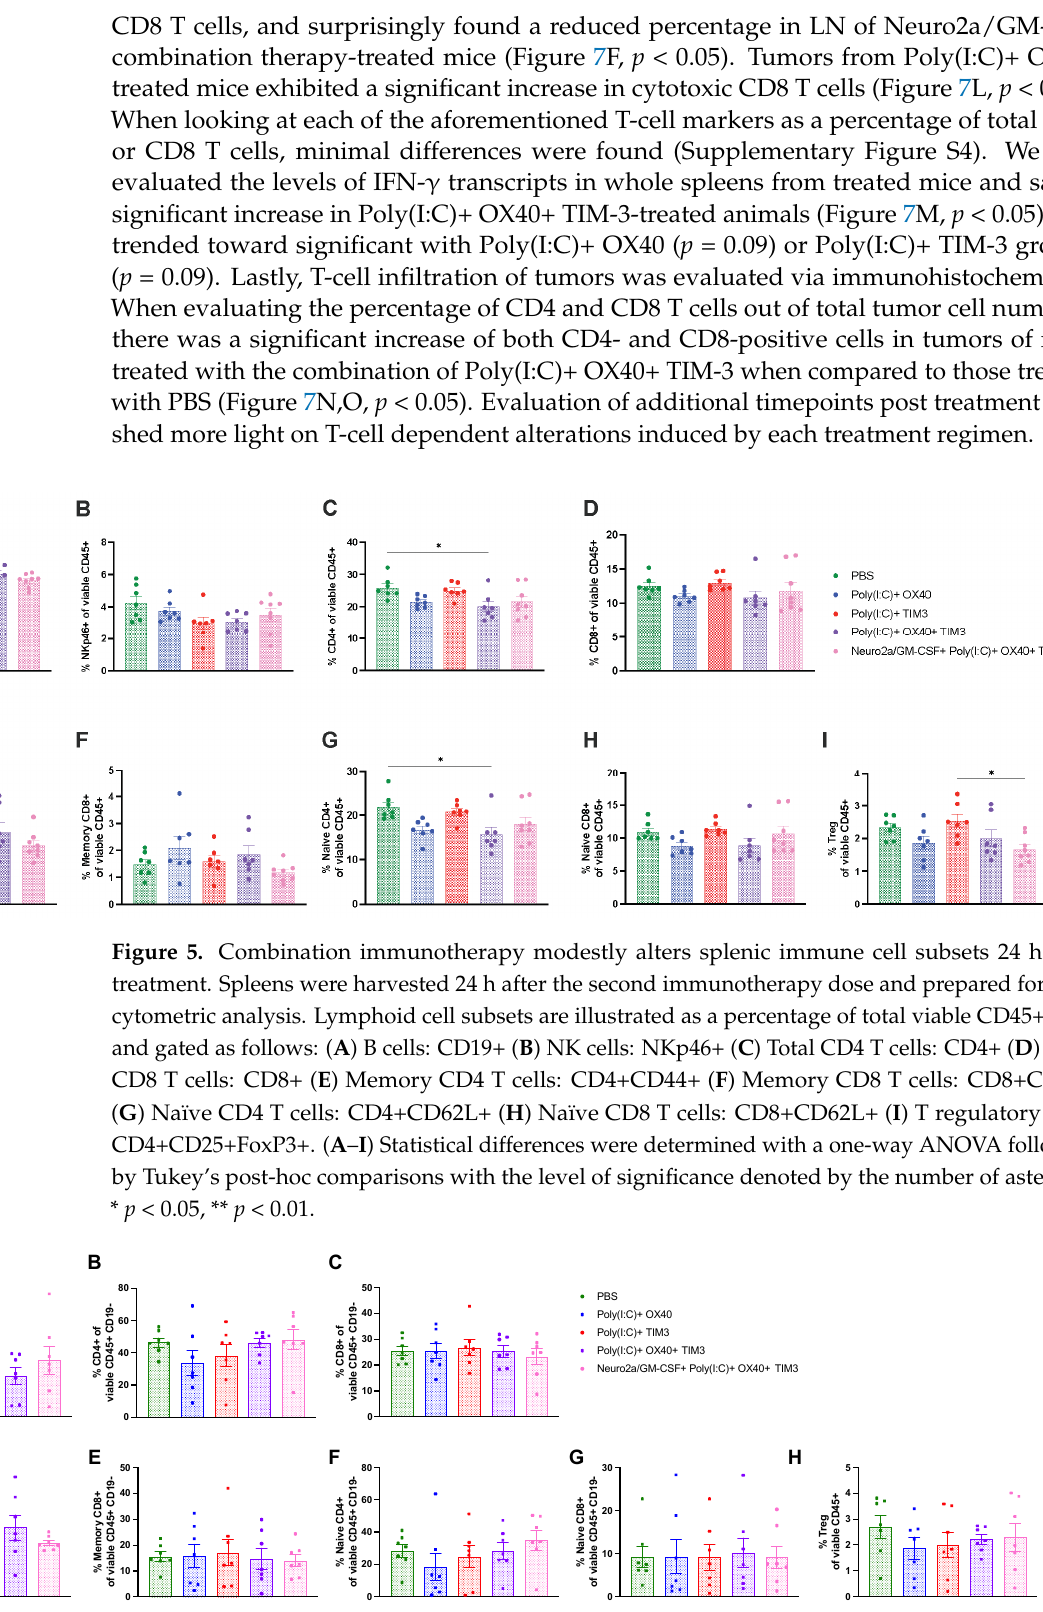
Figure 6. The tumor immune profile is variable 24 h post-intratumoral immunotherapy administration. Tumors were harvested 24 h after the second immunotherapy dose and prepared for flow cy- tometric analysis as described in Section 2. Lymphoid cell subsets are illustrated as a percentage of total viable CD45+CD19- cells and gated as follows: ( A ) NK cells: NKp46+ ( B ) Total CD4 T cells: CD4+ ( C ) Total CD8 T cells: CD8+ ( D ) Memory CD4 T cells: CD4+CD44+ ( E ) Memory CD8 T cells: CD8+CD44+ ( F ) Naïve CD4 T cells: CD4+CD62L+ ( G ) Naïve CD8 T cells: CD8+CD62L+ ( H ) T regu- latory cells: CD4+CD25+FoxP3+. ( A – H ) Statistical differences were determined via a one-way ANOVA and Tukey’s post-hoc comparisons. T-cell functionality markers are minimally different in lymphoid tissues and tumors at 24 h post immunotherapy. This work aimed to identify T-cell-mediated mechanistic differences induced by each immunotherapy regimen by evaluating markers of T-cell functionality or cytotoxicity. Interferon- γ (IFN- γ ) is a pro-inflammatory cytokine that is upregulated during an immune response and is produced by activated T cells [31]. Thus, we evaluated the level of intracellular IFN- γ in both CD4 and CD8 T cells in spleen, lymph nodes (LN), tumor-draining lymph nodes (TDLN) and tumors from mice in each treat- ment regimen. Unexpectedly, there was increased IFN- γ + splenic CD4 T cells in the PBS- injected group as well as the Poly(I:C)+ TIM-3 (Figure 7A, p < 0.05). There was also a slight increase of IFN- γ + CD4 in PBS-injected TDLN when compared to Poly(I:C)+ TIM-3 mice (Figure 7G, p < 0.05). IFN- γ + CD8 T cells were significantly lower in Neuro2a/GM-CSF